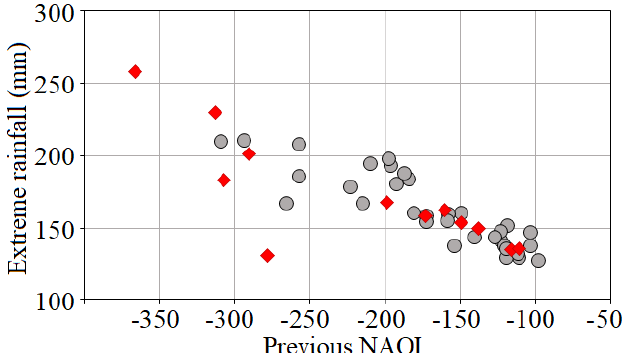
Figure 4. Scatter plot of previous smoothed NAOI and extreme rainfalls, both at daily scale, for m = 14 and l = 39 days. The 45 bivariate observations (1967/1968–2016/2017) at the AR-C rain gauge are depicted by bullets and red diamonds, the latter being the events that occurred between December 2000 and the end of the reference period. The correlation ( r ) between previous NAOI and extreme rainfalls is −